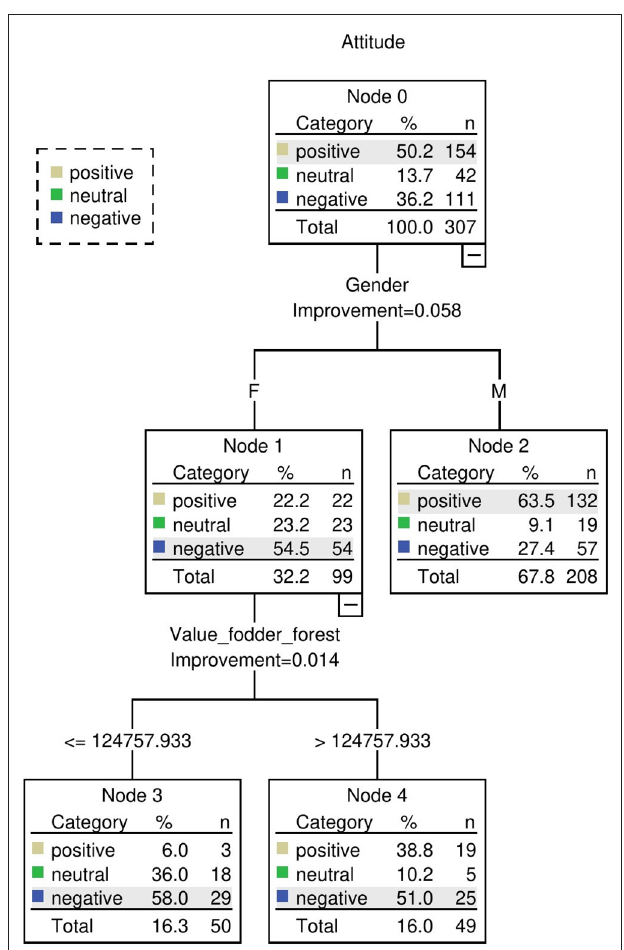
FIGURE 5 | Decision tree of attitudes of local communities towards tiger in Sariska Tiger